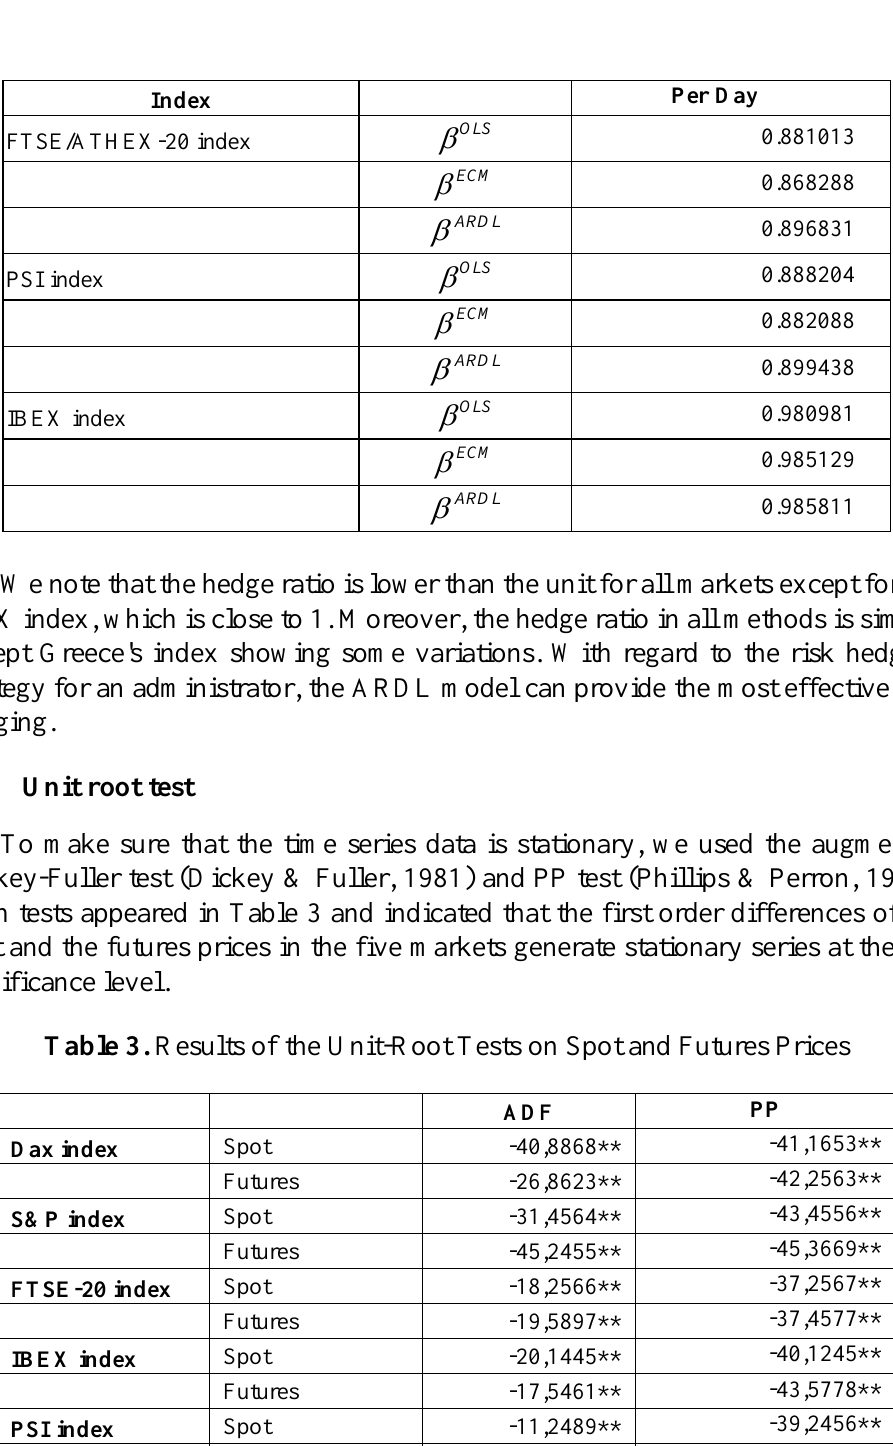
*indicates significance at 5% level, ** indicates significance at 1%